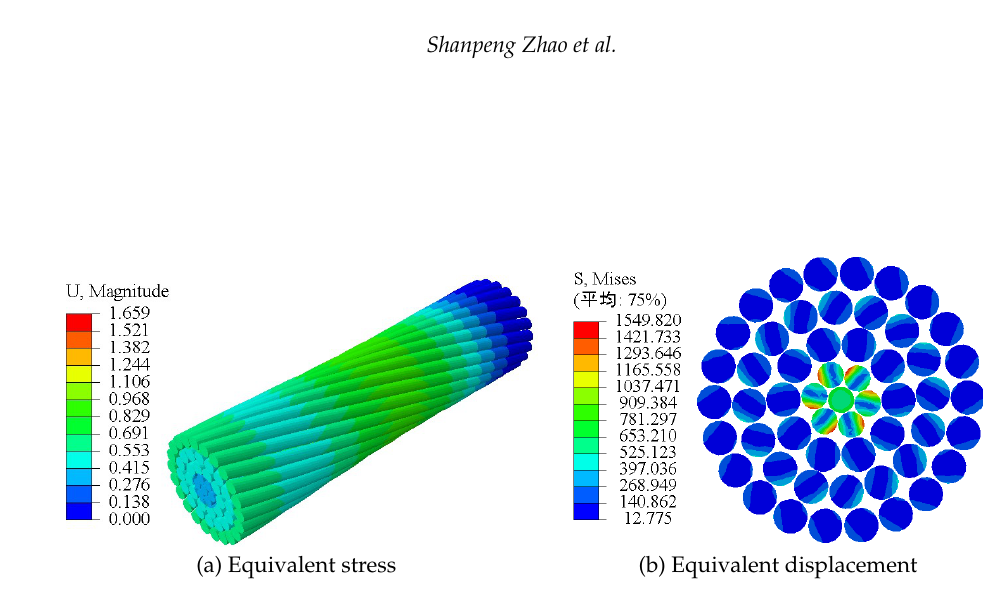
Fig. 7. Integral deformation and equivalent stress nephogram